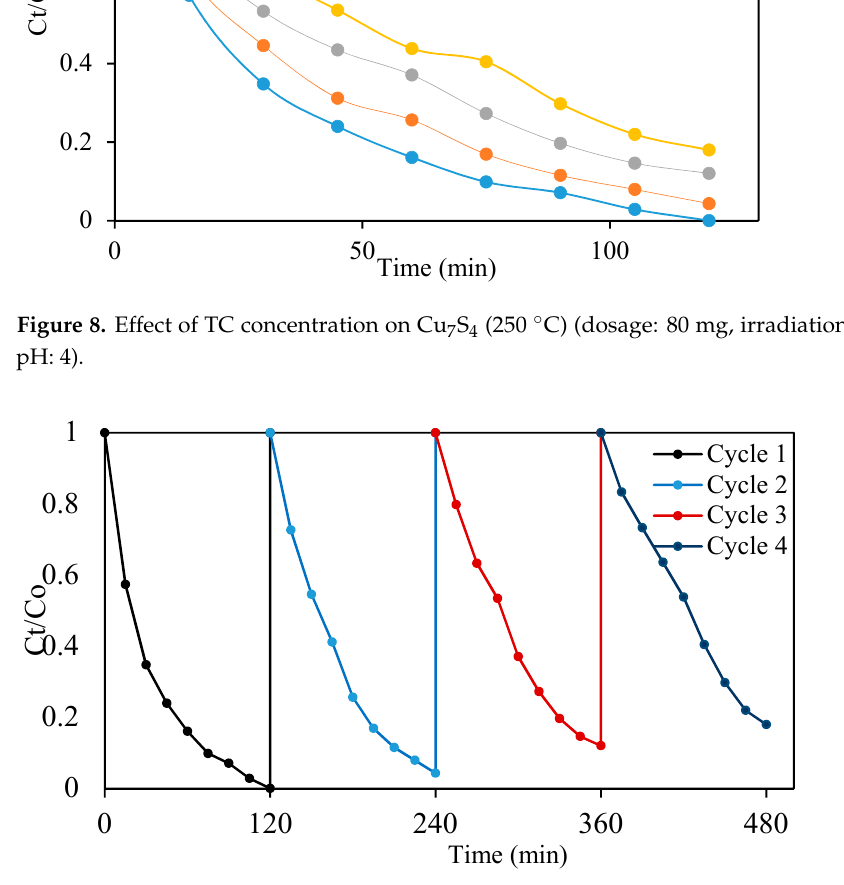
Figure 9. Reusability cycles of TC degradation using Cu7S4 (250 °C) nanocomposite and a solution of 25 mg/L TC.